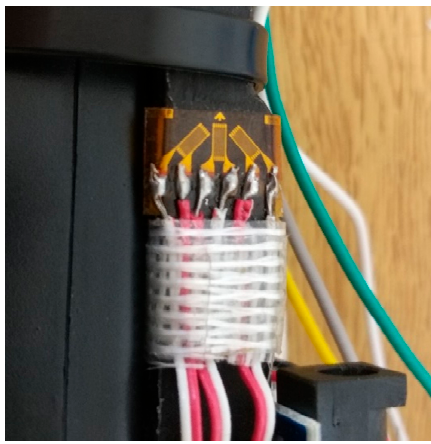
Figure 19. The Rossette strain Figure 19 . The Rossette strain gauge. Figure 19 . The Rossette strain gauge.